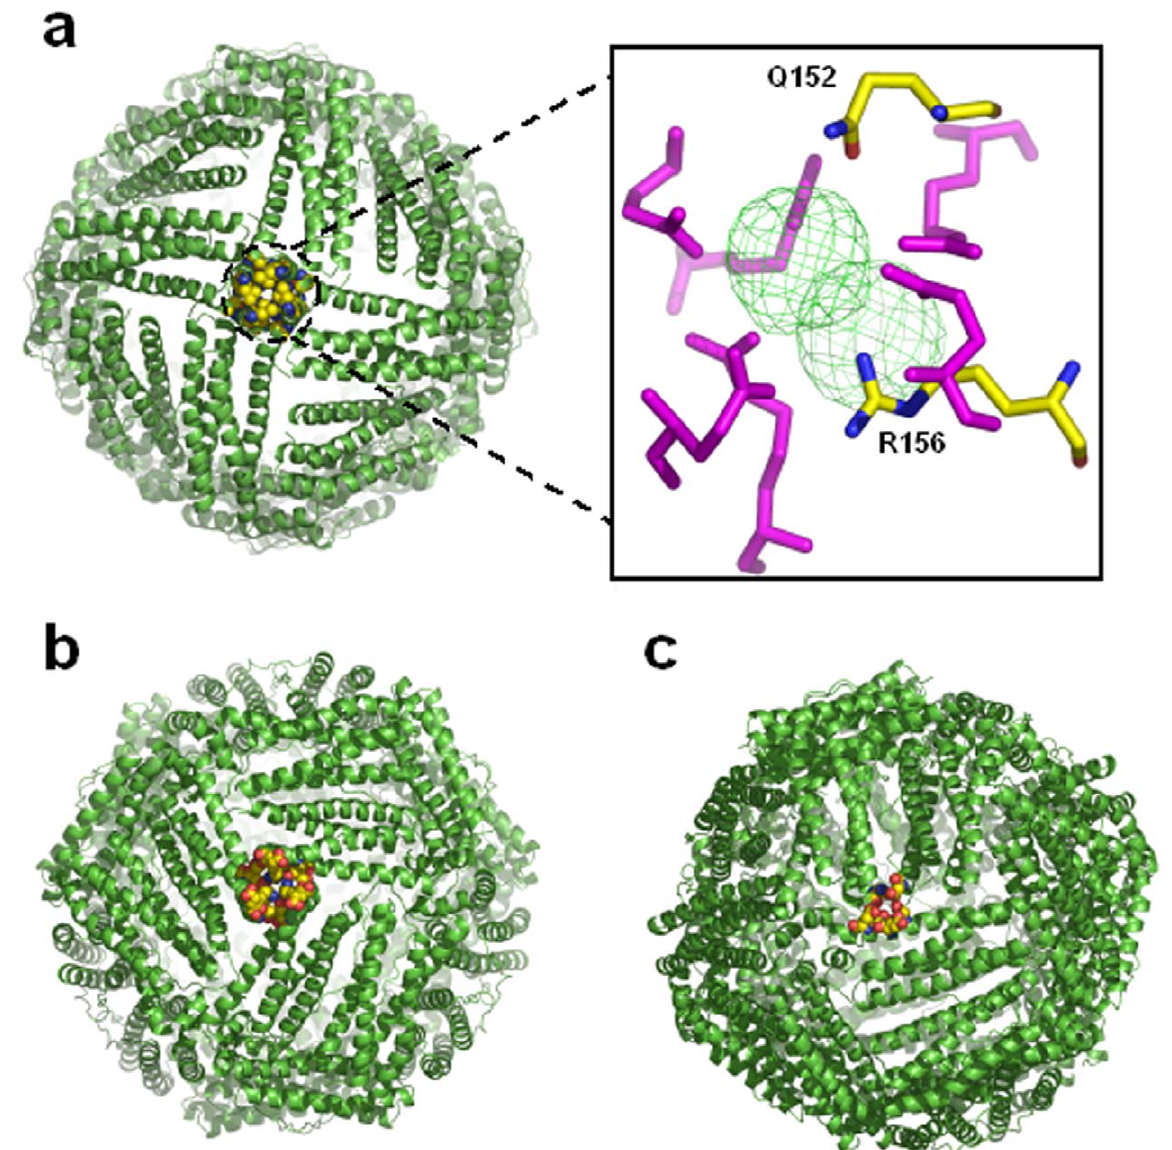
Figure 7. Channels and pores of Mtb SeMet-BfrA. Molecular representation of the ( a ) four-fold channel, ( b ) three-fold channel and ( c ) the B- pore in the Mtb SeMet-BfrA protein. The amino acids that line the channel or the pore are shown in the CPK representation and the remaining portions are shown in the cartoon representation. The two spherical electron density peaks (in a F o 2 F c difference map contoured at 5.0 s ) of an unidentified ligand at the four-fold axis in the structure of Mtb SeMet-BfrA are shown as inset to figure 7a. The residues Q152 and R156 are shown as sticks colored by atom type from one monomer whereas symmetry related residues at the 4-fold are colored in magenta.